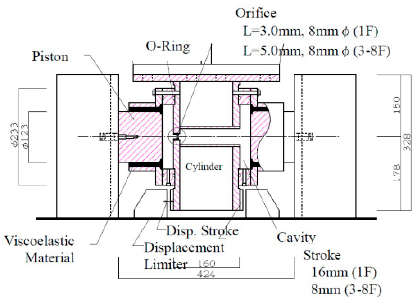
Figure 2. Damper configuration details.